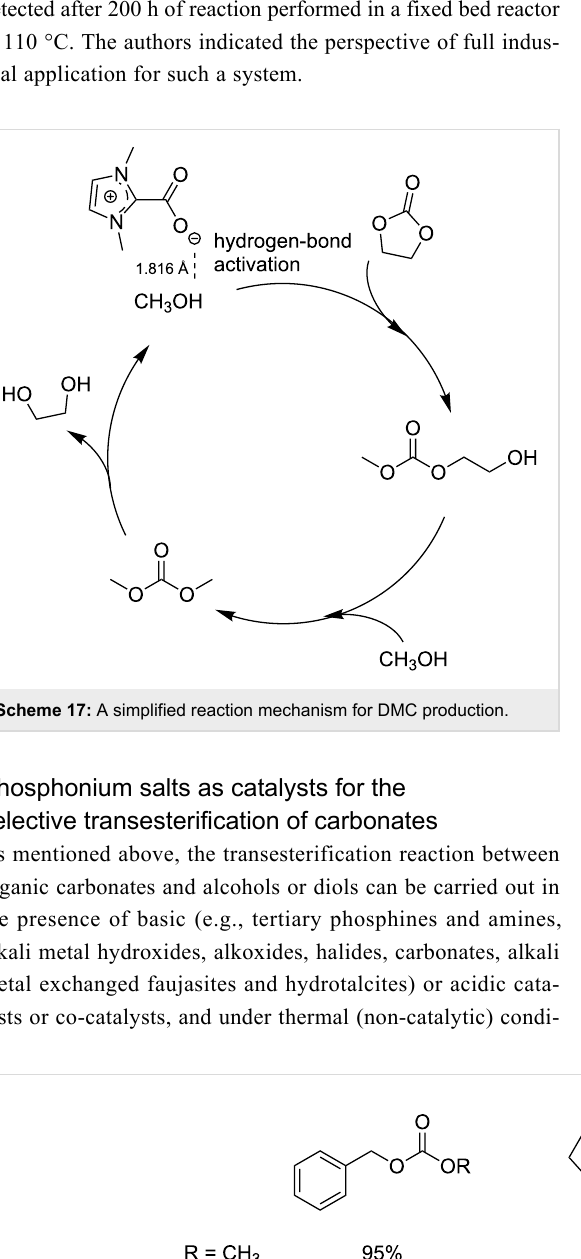
reaction methylimidazole and DMC. Under the best found reac- tion conditions (1 mol % catalyst loading with respect to EC,